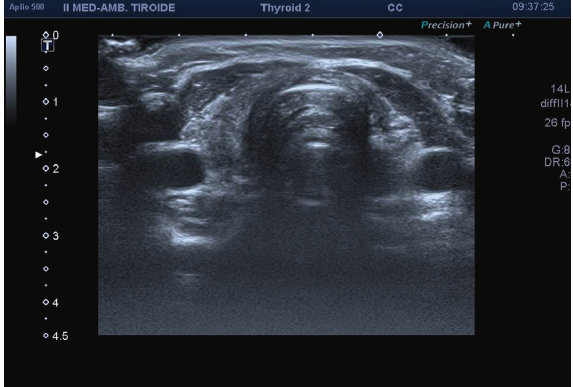
Figure 1: Thyroid ultrasound revealed an atrophic gland without